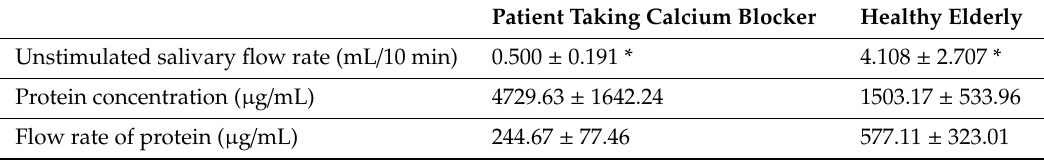
Table 1. Unstimulated salivary flow rate, protein concentration, and flow rate of protein on patient taking calcium blocker and healthy elderly. Measurements are expressed as mean value ± SD.